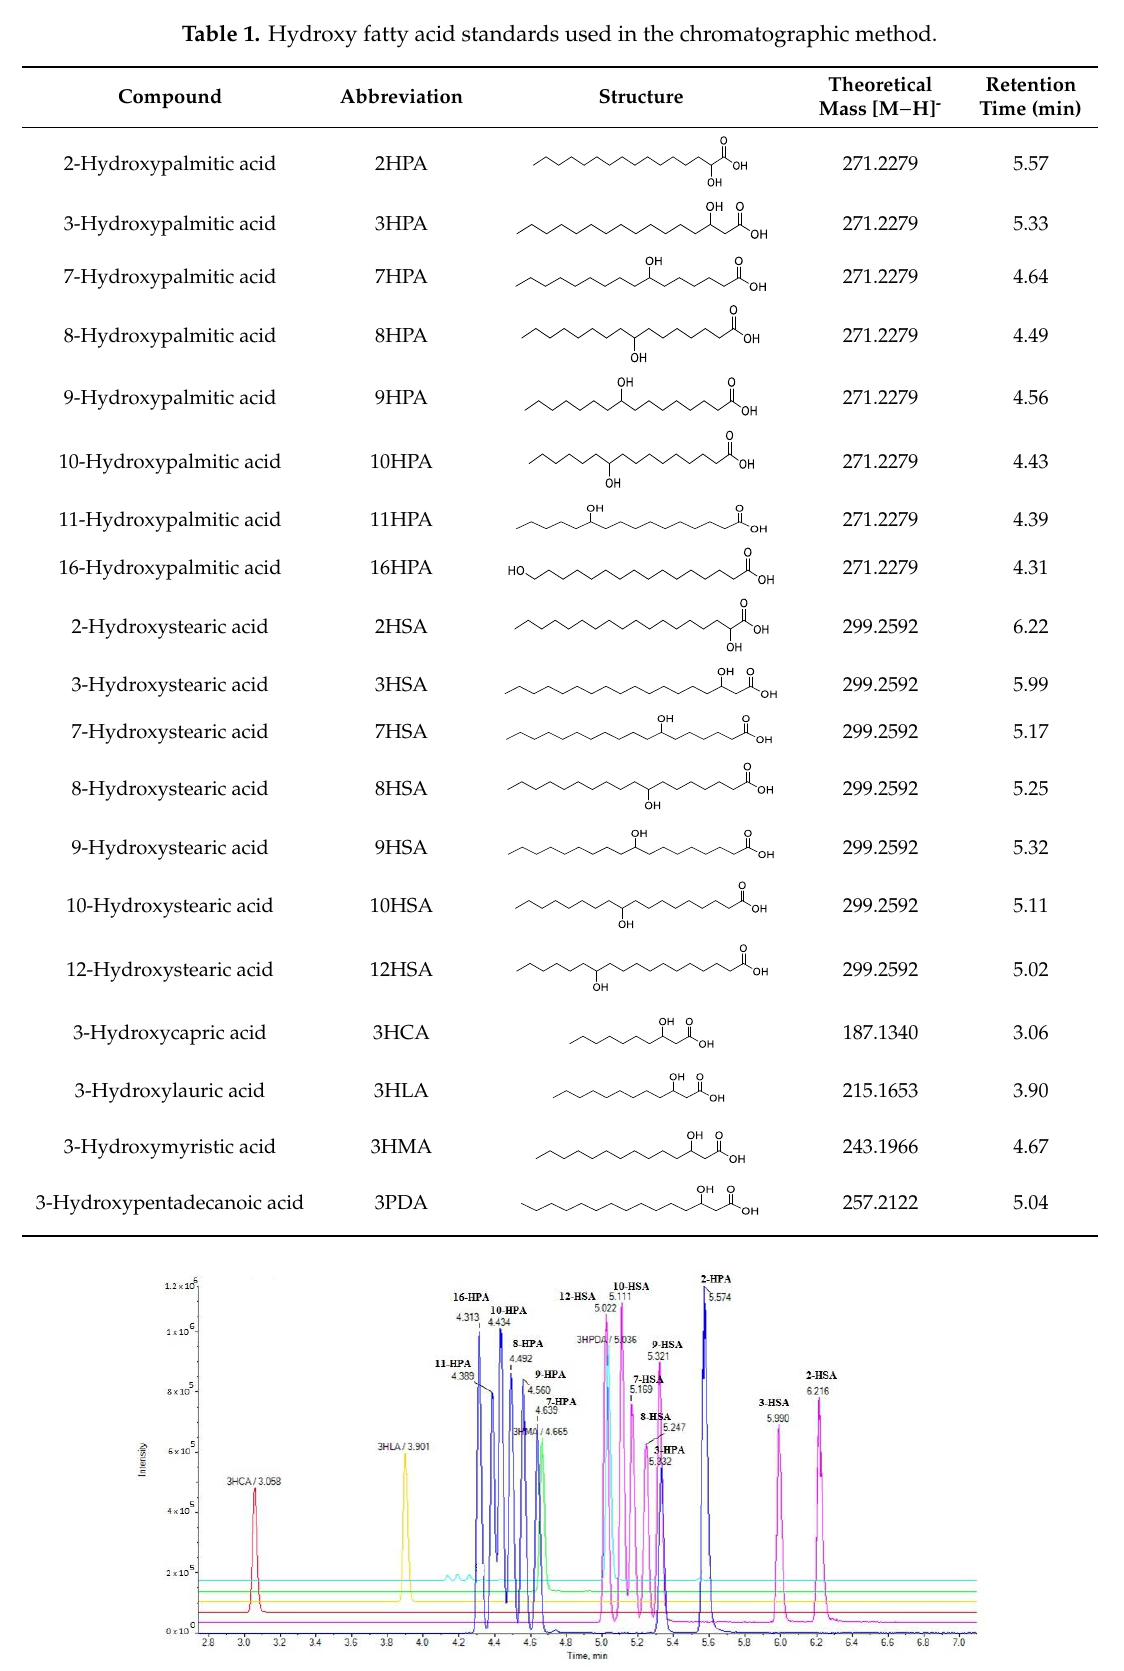
Figure 1. Extracted ion chromatograms (EICs) of hydroxy fatty acids in a standard solution (1 µg/mL).